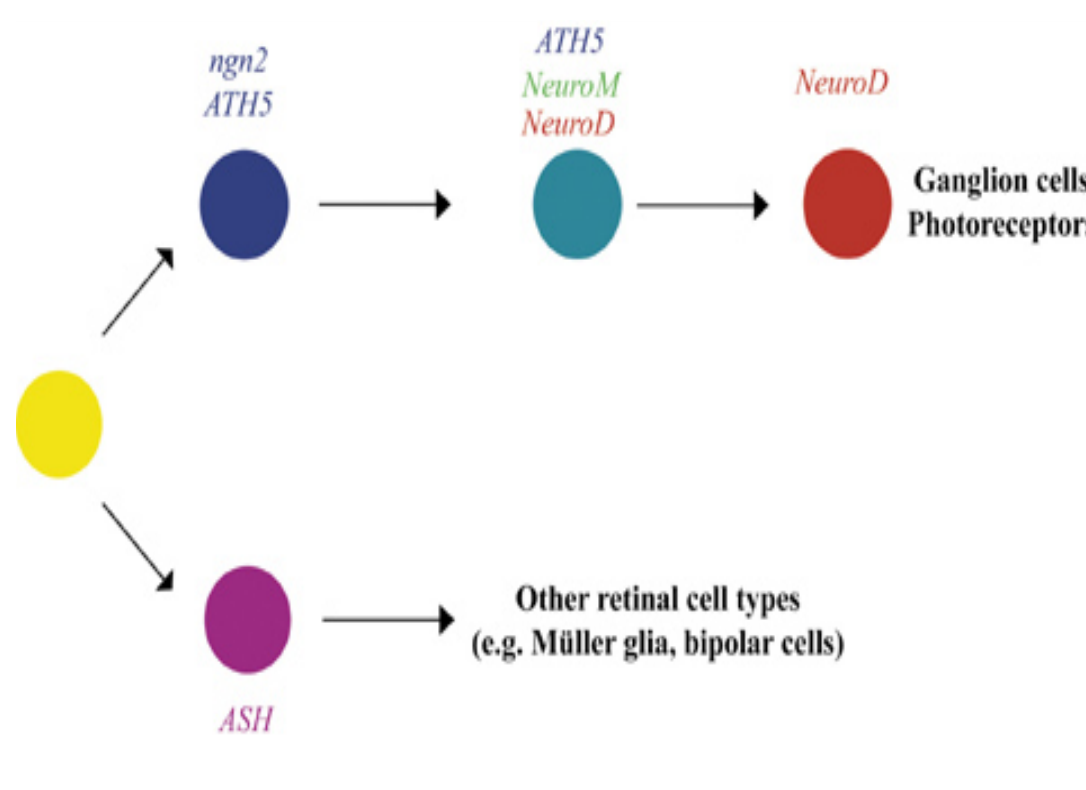
FIGURE 5. The determination of neural cell types in the retina. Multipotent precursor cells may express either ngn2 and ATH5 or ASH1. ngn2- and ATH5-expressing precursors subsequently express NeuroM/ATH3 and NeuroD and eventually differentiate into ganglion cells and photoreceptors. ASH1-expressing precursors differentiate later in development other retinal cell types such as Müller glia and bipolar